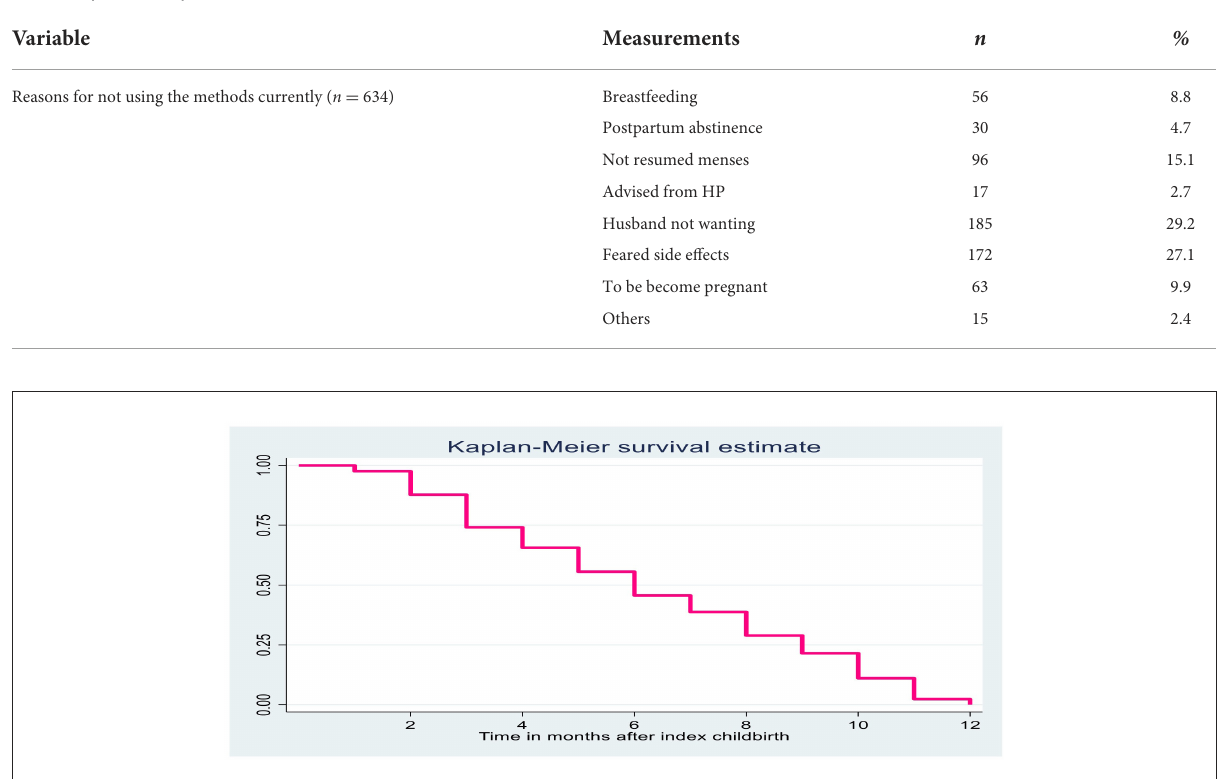
FIGURE1 Kaplan Meier survival function curve for postpartum contraception timing after index childbirth among married